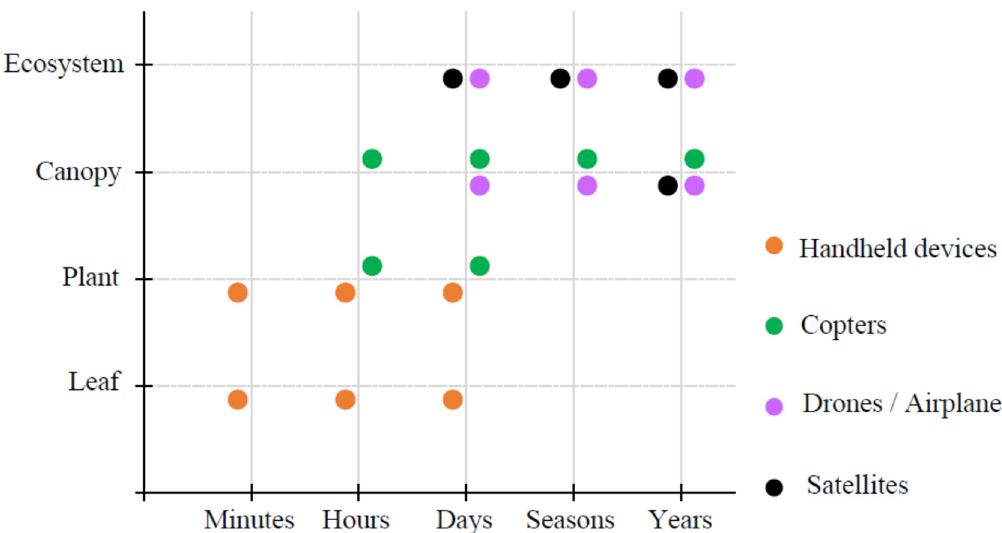
Figure 4. Spatial (from leaf to ecosystem(s)) and temporal (from seconds to years) scales of plant remote sensing on basis of manual measurements using handheld devices and different flying platforms (copters, drones, airplanes, and satellites).